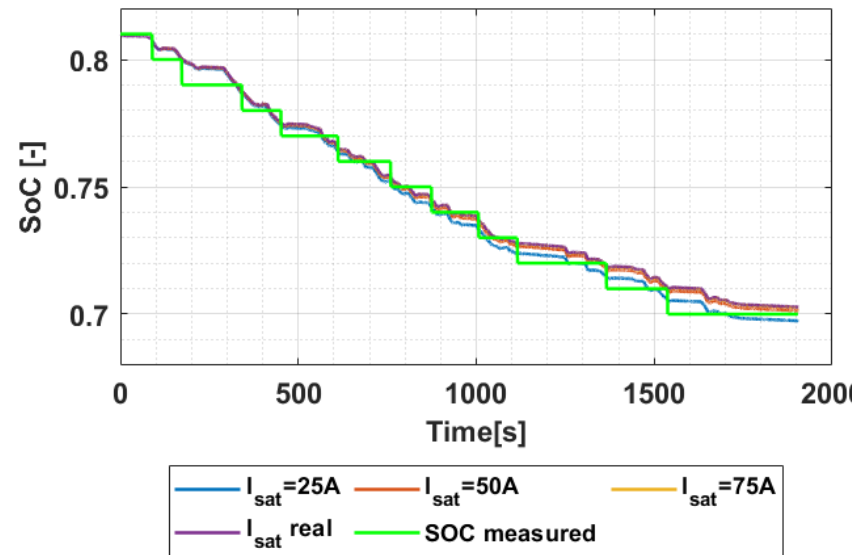
Figure 16. Comparison of the battery state of charge trajectories estimated by the model considering different saturation currents with respect to the experimental battery state of charge of DM25.